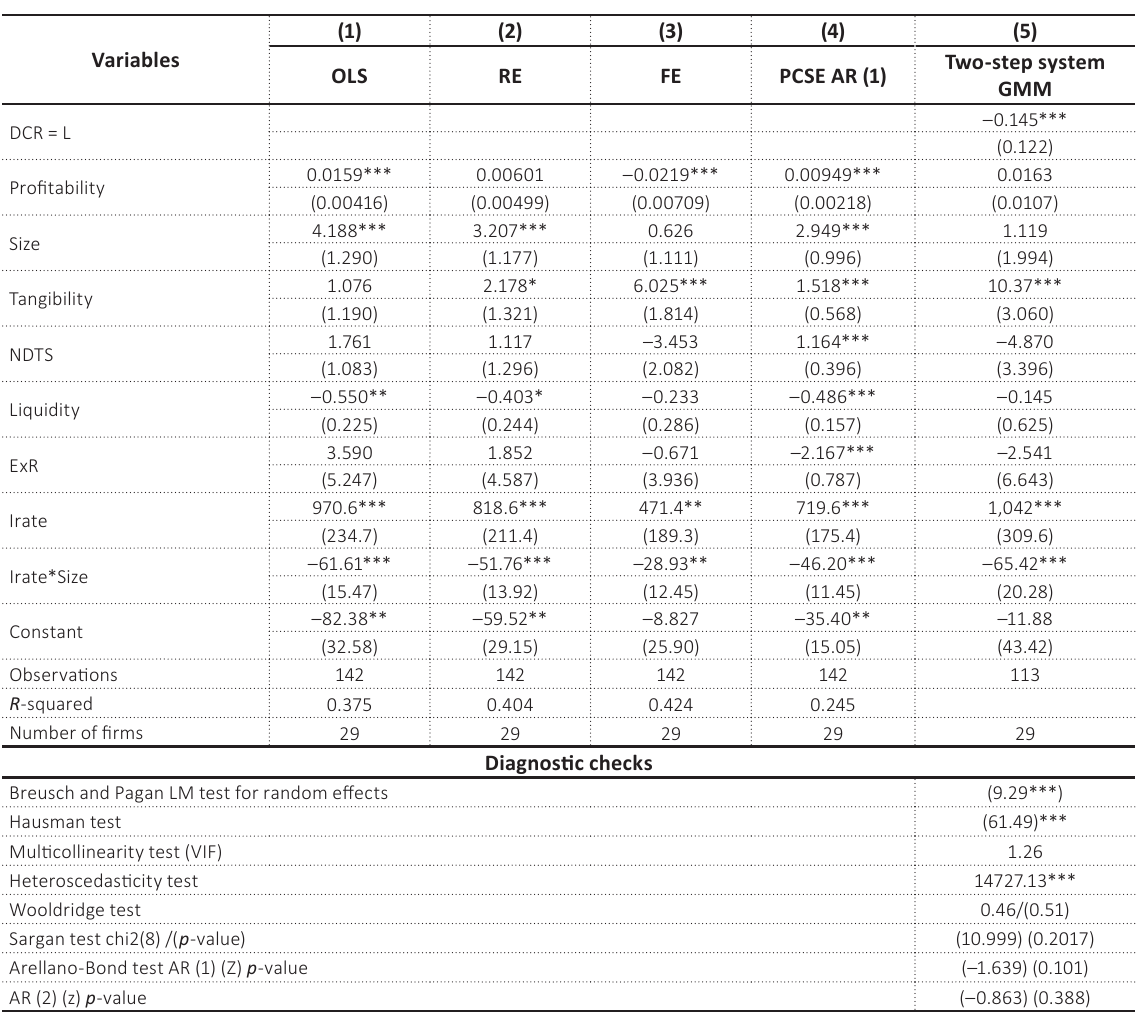
Table 5. Nonlinear